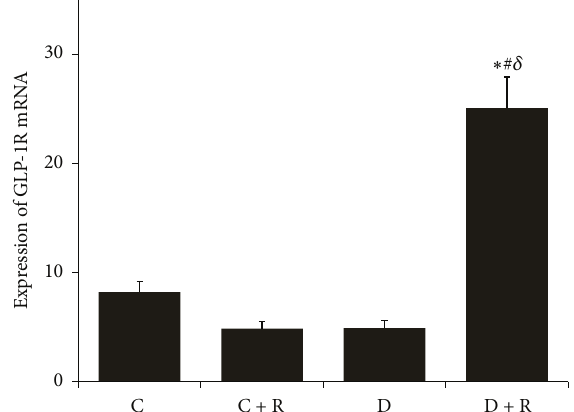
Figure 4: The crossing point (Cp) value of GLP-1R mRNA in the hypothalamus by RT-PCR in four groups. ∗ 𝑃 < 0.01 compared with D group; # 𝑃 < 0.05 compared with C group; 𝛿 𝑃 < 0.01 compared with C + R